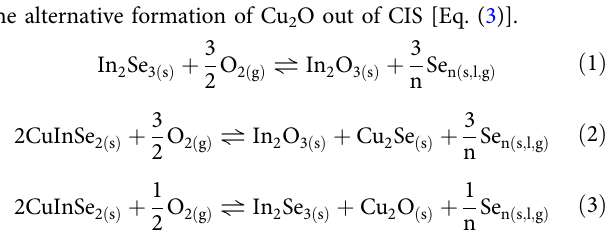
Fig. 4 for detailed point defect reaction energetics). The thermodynamic driving force is a necessary but insuf fi cient condition for a reaction to happen (cf. Supplementary Note 1).